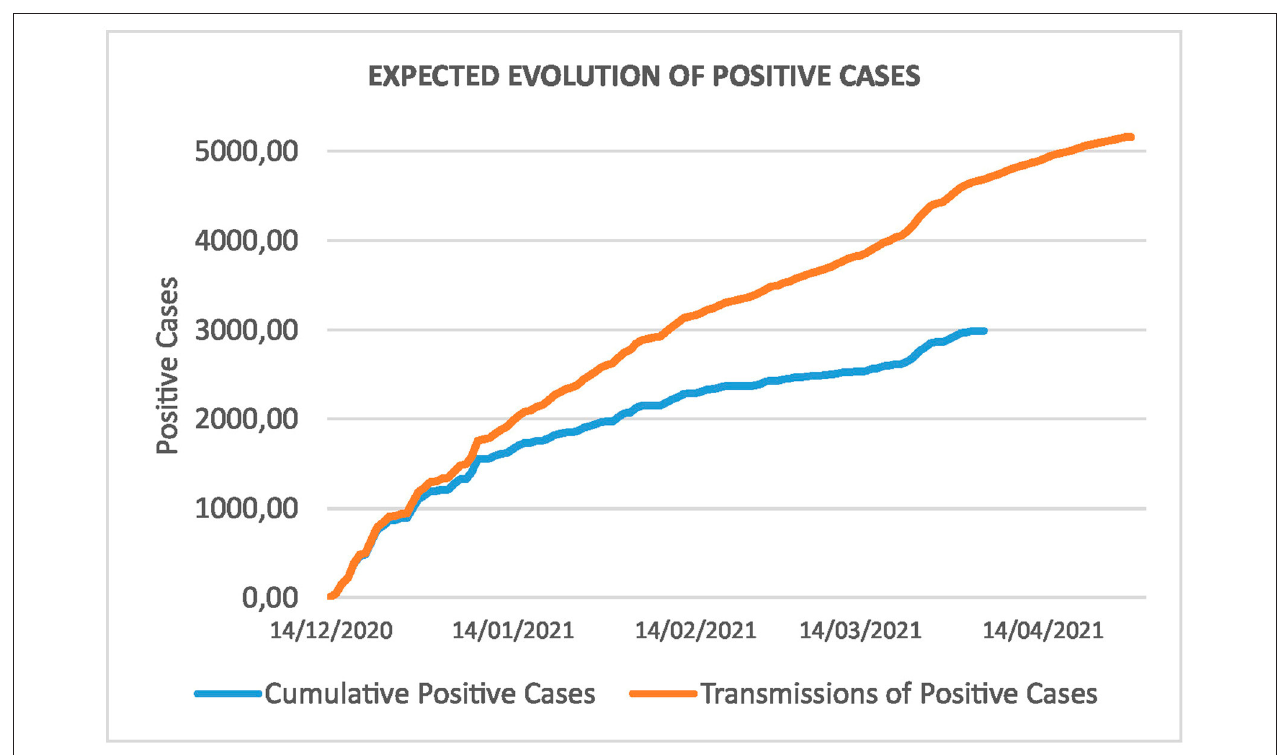
FIGURE 8 | Cumulative cases of newcomers and estimated